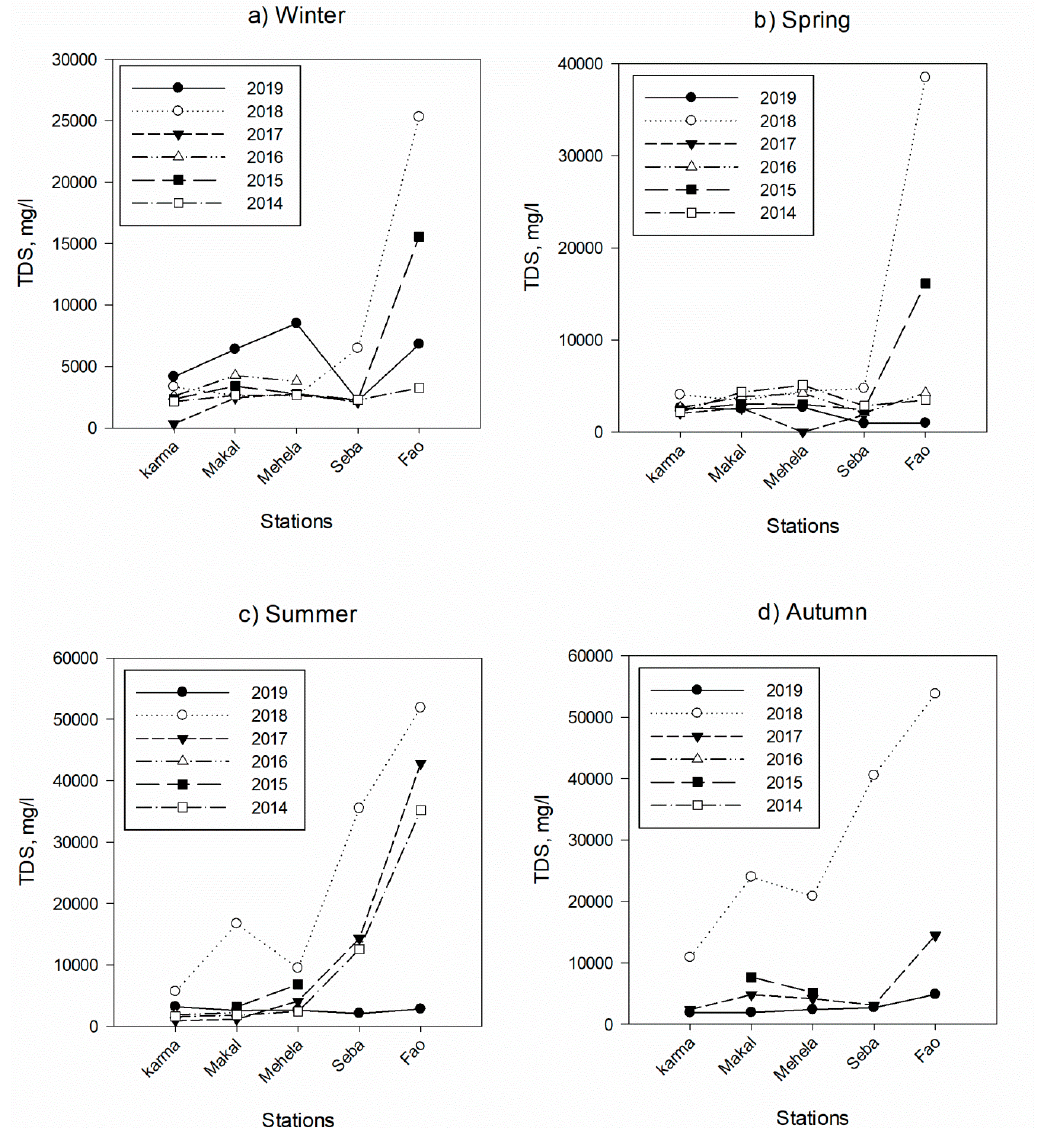
Figure 4. Comparison of TDS concentrations of the selected stations for four seasons during the period of 2014 to 2019.